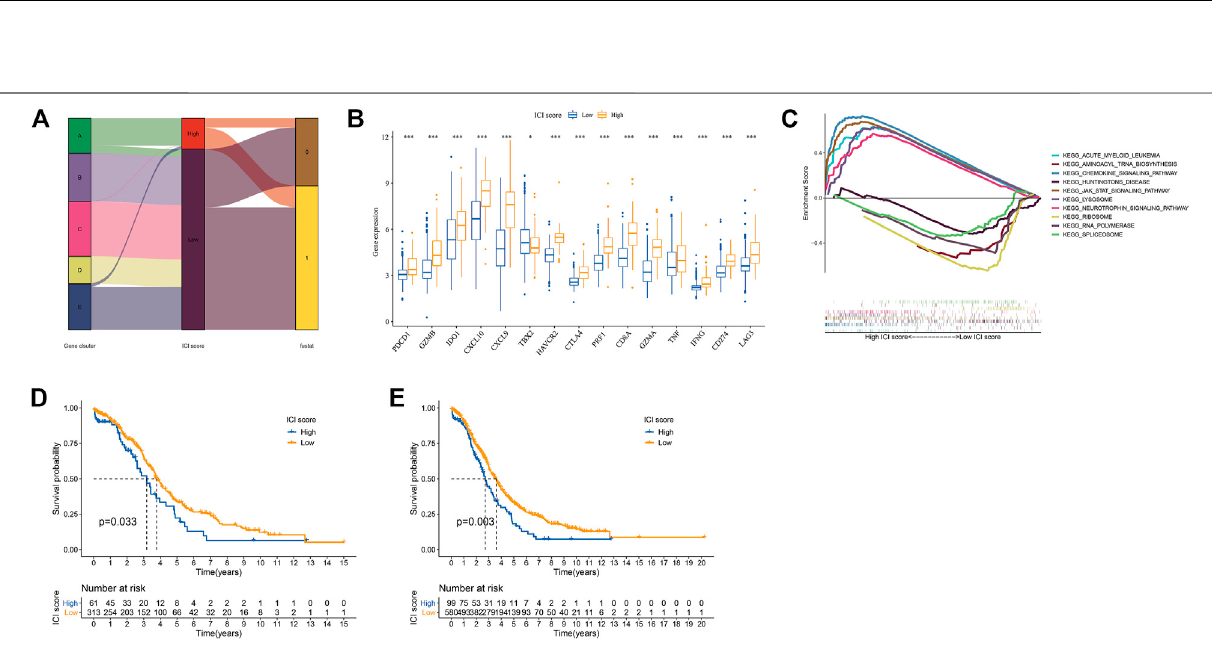
Frontiers in Cell and Developmental Biology |